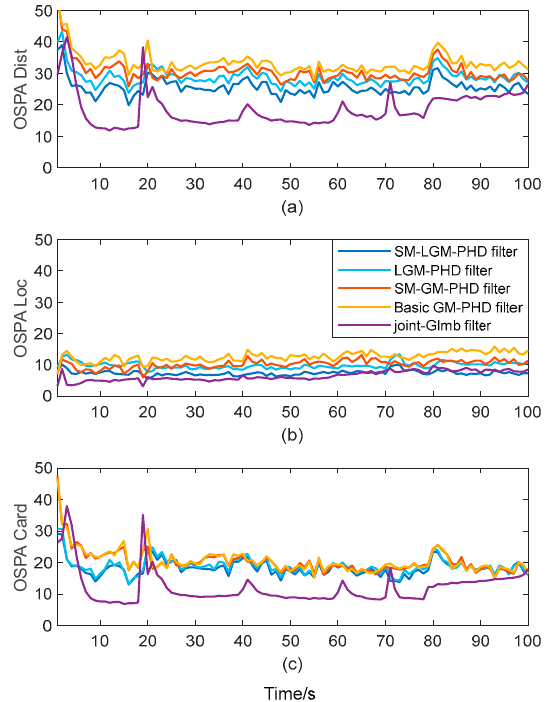
Figure 9. The average OSPA of different filters in example 1 (CV motion model) for 100 sample runs when T s = 1 s ( T i = 2 ms, λ = 104, p D , k = 0.8). ( a ) Average OSPA distances of different filters. ( b ) OSPA locations of different filters. ( c ) OSPA cardinalities of different filters.